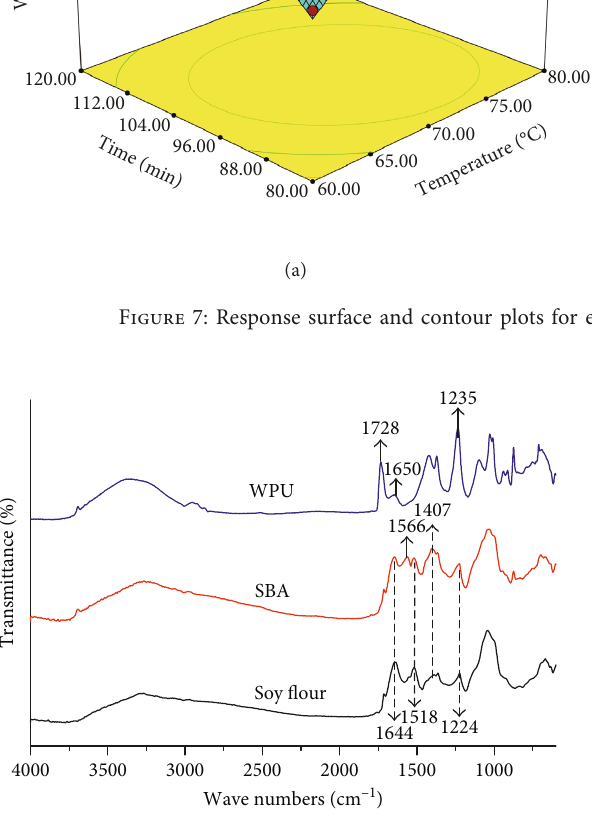
Figure 8: FTIR spectra of WPU, soy flour, and SBA with 12wt.% WPU